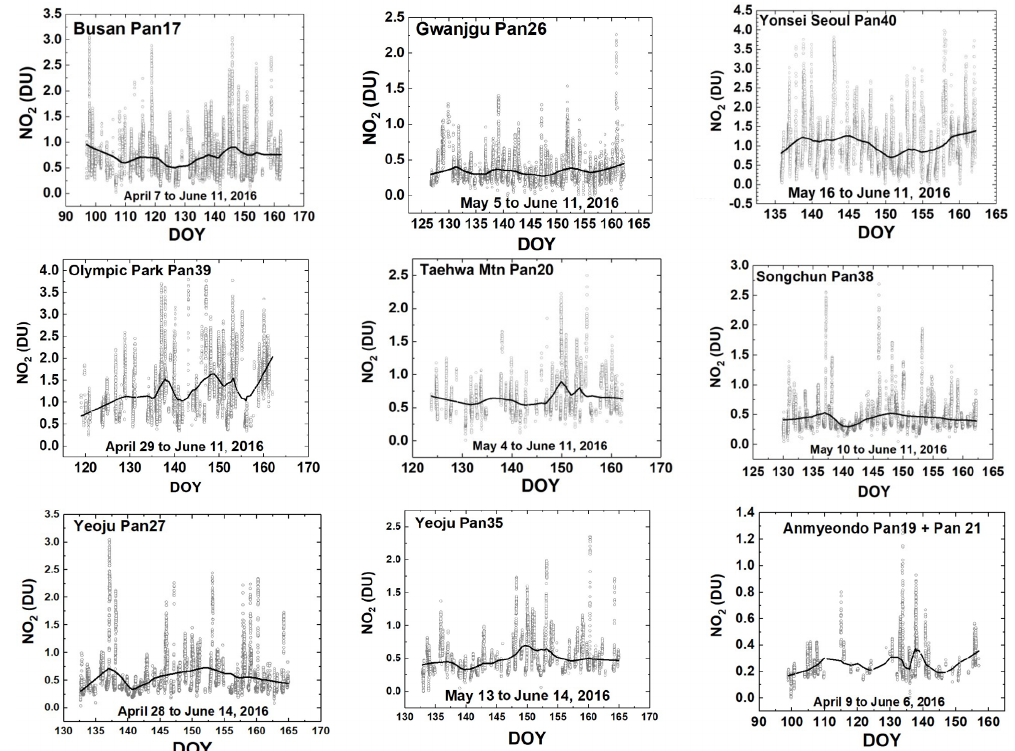
Figure 4. NO 2 time series vs. day of the year (DOY) and diurnal variability (daily vertical extent) at nine Pandora sites. Notice the very high NO 2 amounts in Seoul and nearby Olympic Park. The black curves are approximate weekly least squares running averages. Note that the vertical scales are different for each site to show the daily variability relative to the running